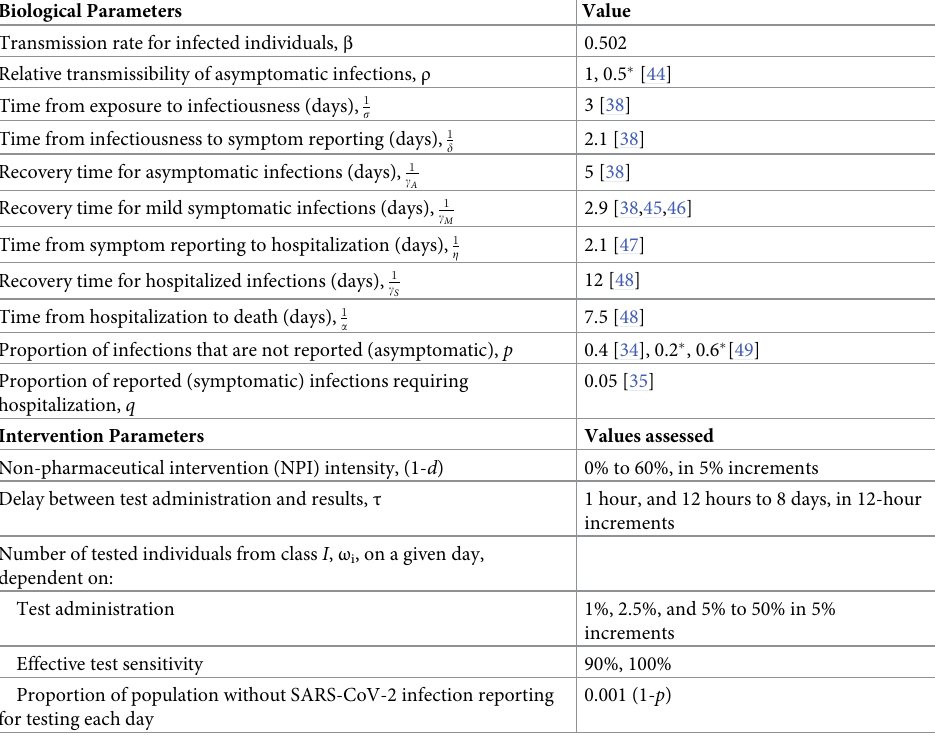
Table 1. Model parameters. Where no reference is provided, values were assumed. Values shown with an asterisk ( � ) were considered in sensitivity analyses. The transmission rate, β , was calibrated to yield R 0 = 2.5 using the next genera- tion matrix method. Transmission rate shown is for primary parameters but was recalibrated for each set of sensitivity